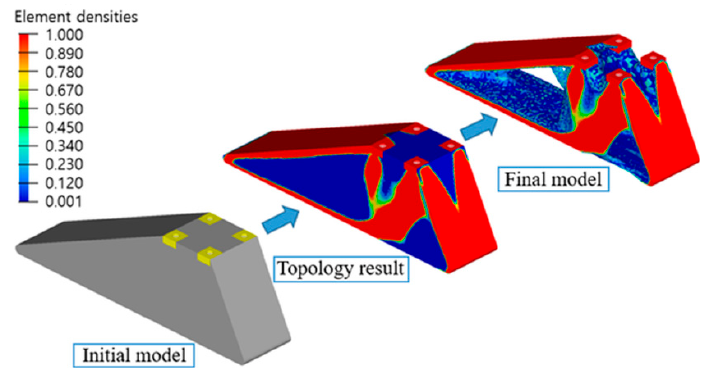
Figure 4. Topology optimization process of designed prosthetic foot. Reproduced with permission from [42].